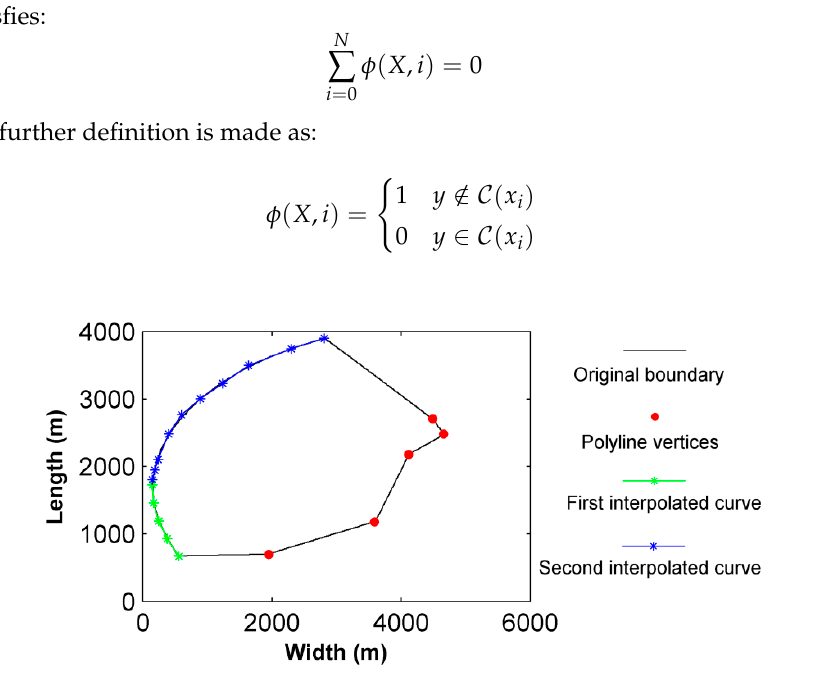
Figure 3. Schematic of the boundary handling technique for the optimization using the coordinate